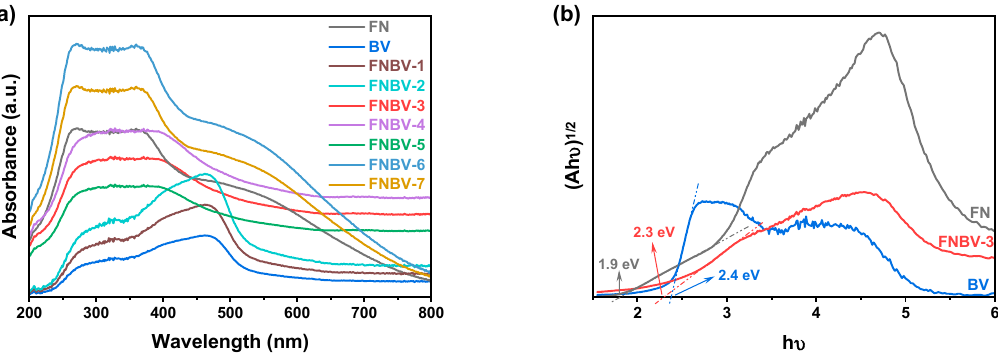
Figure 6. UV–vis diffuse reflectance spectra of all samples ( a ) with (Ah υ ) 1/2 vs. h υ curves ( b ).